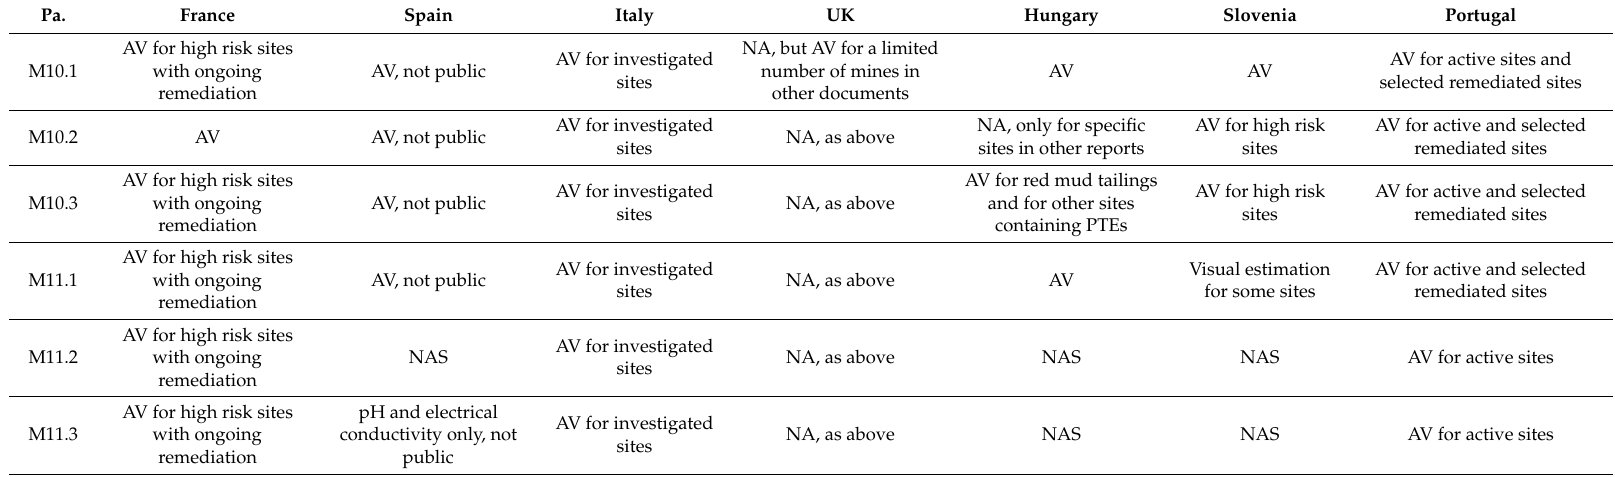
Table 4. Key “metal-centric” valorisation parameters—data availability in di ff erent EU countries (AV—Available, NA—Not Available, NAS—Not Assessed).